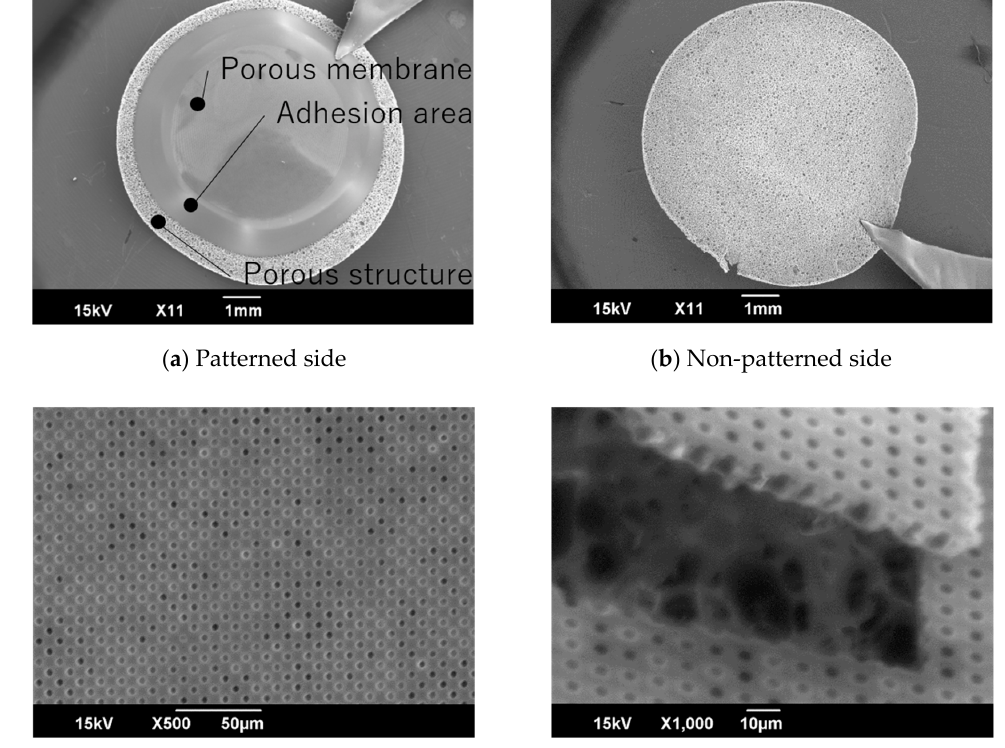
Figure 6. SEM images of the MIS. The porous membrane adhered on the Alvetex sca ff old ( a ). There was no damage on the unpatterned surface of the Alvetex sca ff old ( b ). All pores were opened on the porous membrane ( c ). The thickness of the porous membrane was about 8.3 µ m ( d